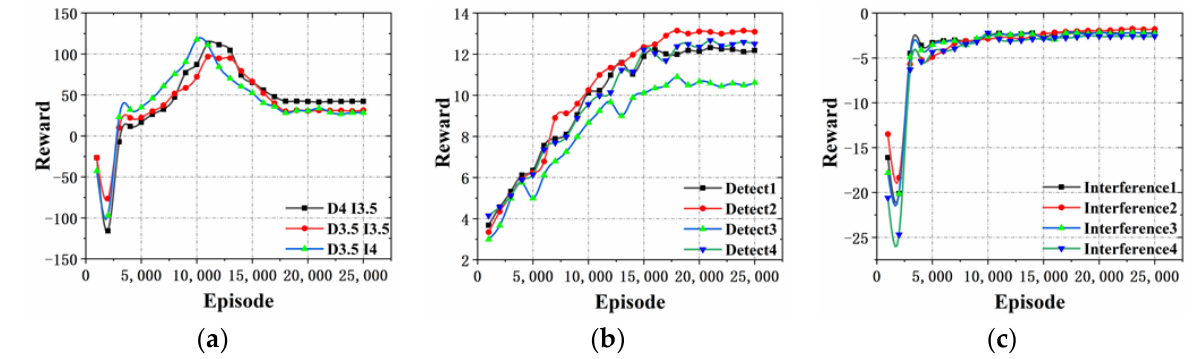
Figure 11. Experimental reward function curves for the multi-agent covert confrontation environment: ( a ) reward function curves for the blue detection multi-agent and the red interference multi-agent for different acceleration parameters; ( b ) curves of the reward function for the blue detection agents; ( c ) curves of the reward function for the red interference agents.